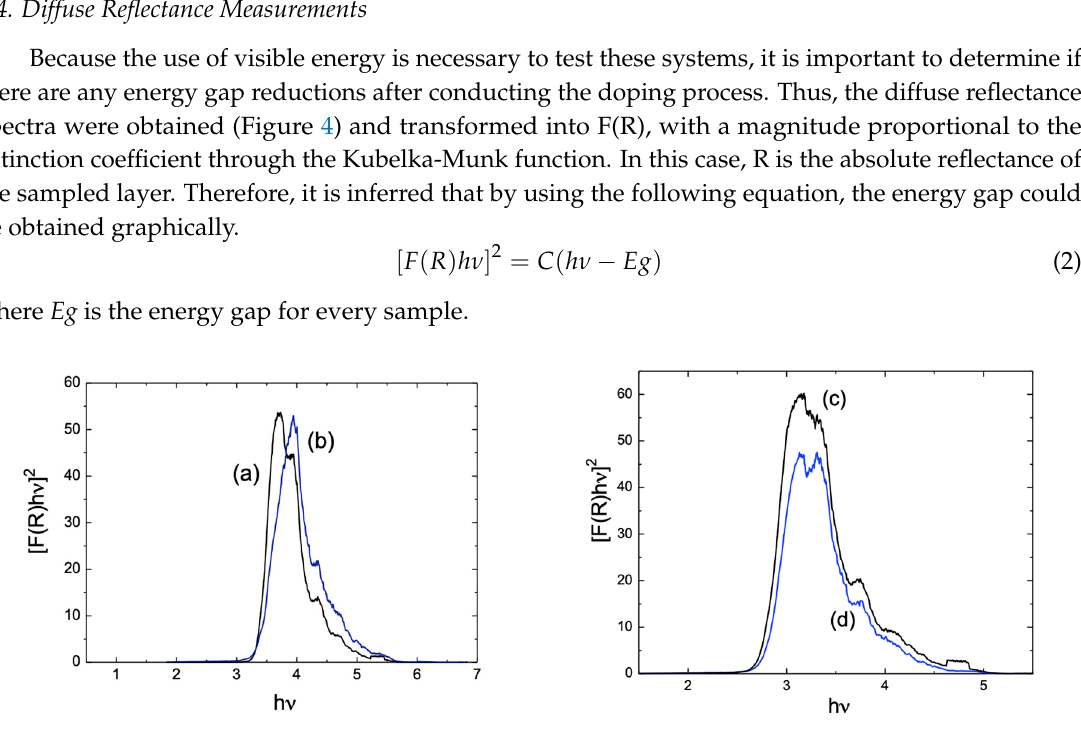
Figure 4. Reflectance diffuse measurements for ( a ) N-TiO 2 , ( b ) TiO 2 , ( c ) N-Bi 2 MoO 6 , and ( d ) Bi 2 MoO 6 , compounds. Table 2. Gap values for TiO 2 , Bi 2 MoO 6 , N-TiO 2 , and N-Bi 2 MoO 6 catalysts. Compound